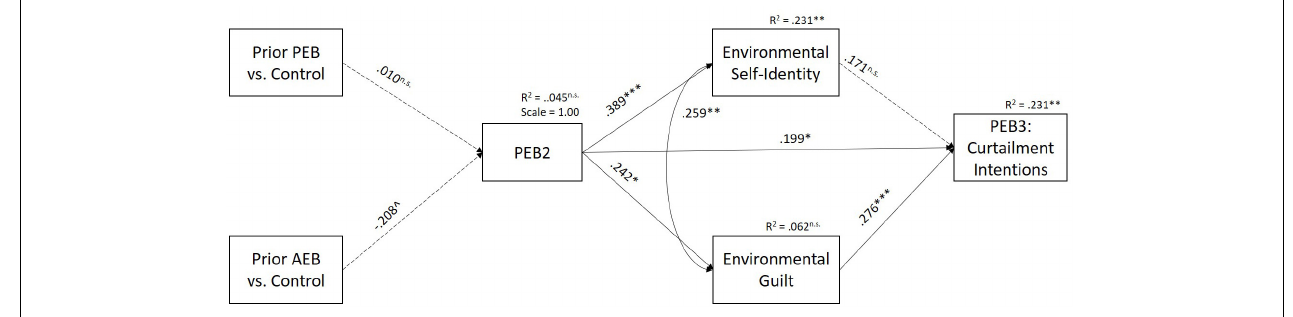
FIGURE 3 | Results of hypothesized direct effects in model testing spillover from PEB2 performance to PEB3 curtailment intentions, Study 2. PEB, pro-environmental behavior. Dashed lines represent p > 0.05. Environmental self-identity and environmental guilt refer to Time 2 measures, which were assessed after PEB2. Only major theorized paths are shown in figure, though all indirect and direct paths are modeled. ∗∗∗ p < 0.001; ∗∗ p < 0.01; ∗ p < 0.05; ˆ p <